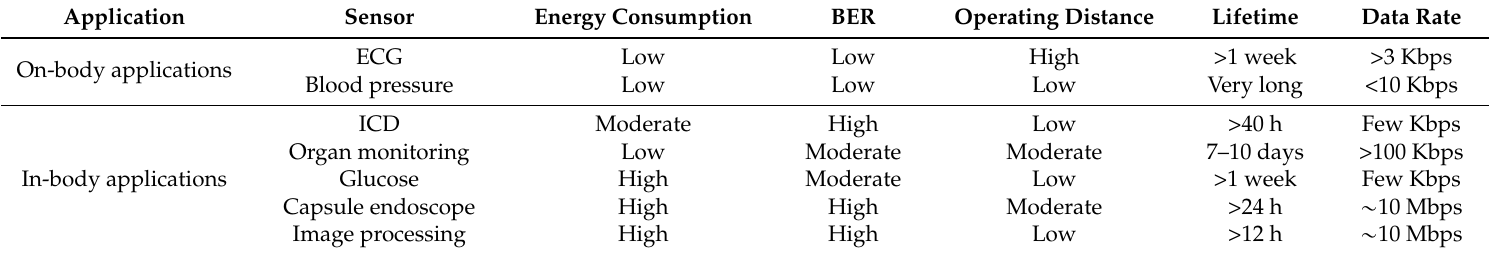
Table 10. The Key Factors of Selected In-Body and On-Body WBAN Applications [6,7,20].